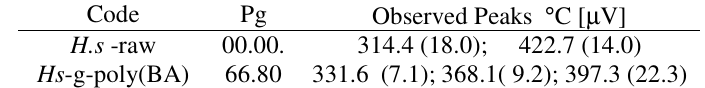
Table 2. Differential thermal analysis of Hibiscus sabdariffa and its graft copolymers